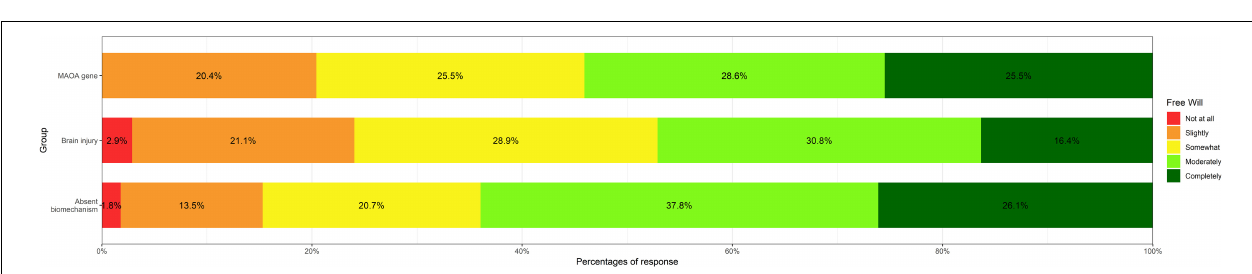
FIGURE 3 | Plot of proportional cross-tables (contingency tables) showing the response to the question to which degree the offender had a free will at the time of